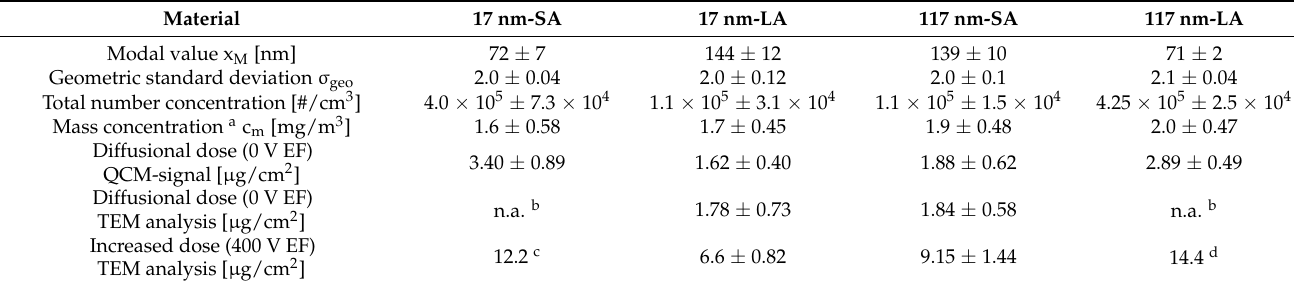
Table 2. Characteristics of TiO 2 aerosols and measured or calculated deposited surface doses on cell cultures.